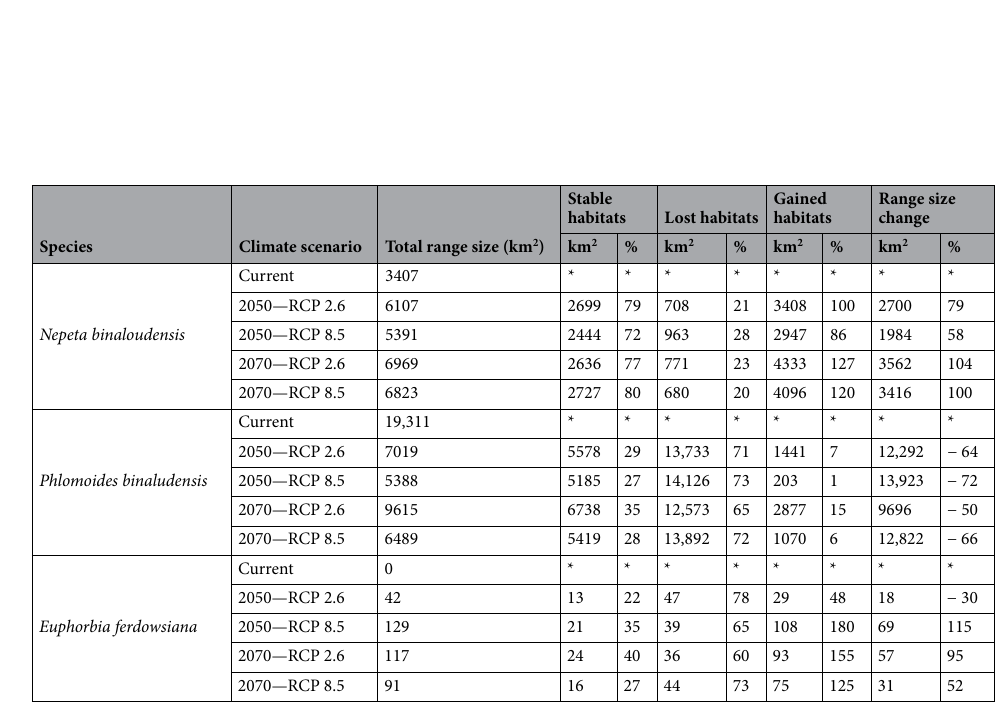
Table 2. The range changes for the studied species under climate change conditions in